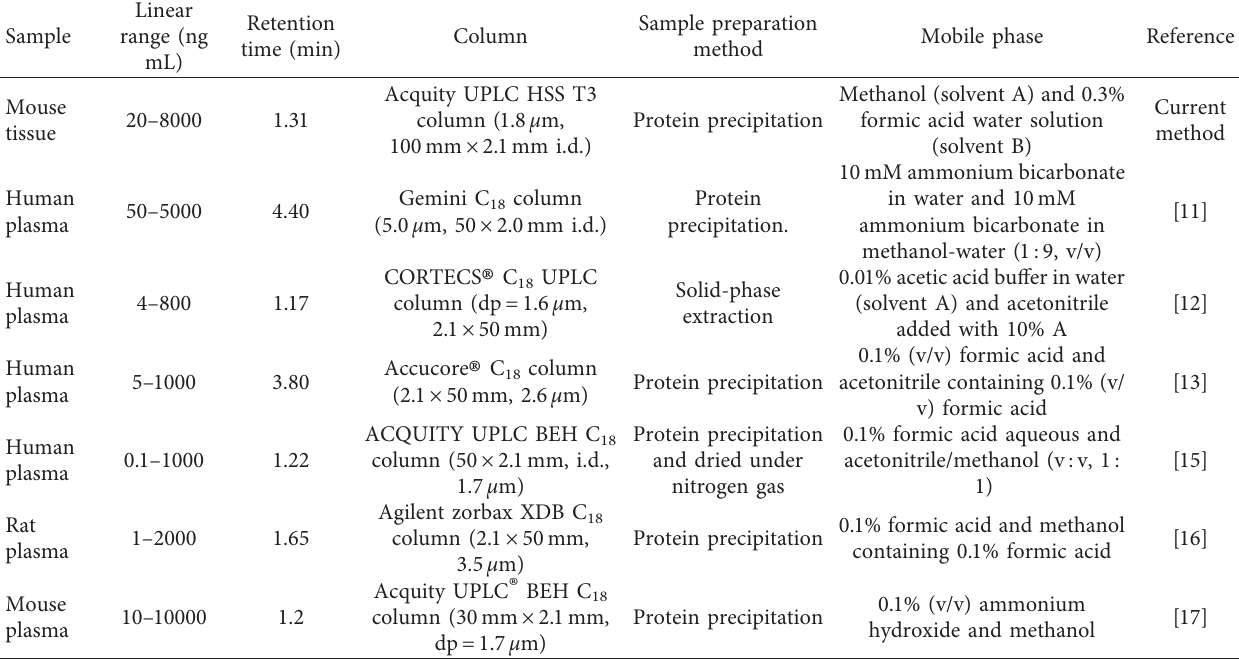
Figure 3: Chromatogram of the elution of a high-quality control sample using a “duplicated” solvent gradient: (a) crizotinib (I) and apatinib (II) and (b) the “duplicated” Table 1: The differences between the current method and some previously developed methods.